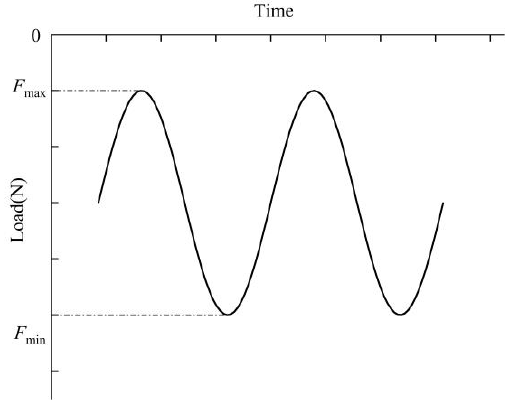
Figure 3. The fatigue load curve of the three-point bending test.